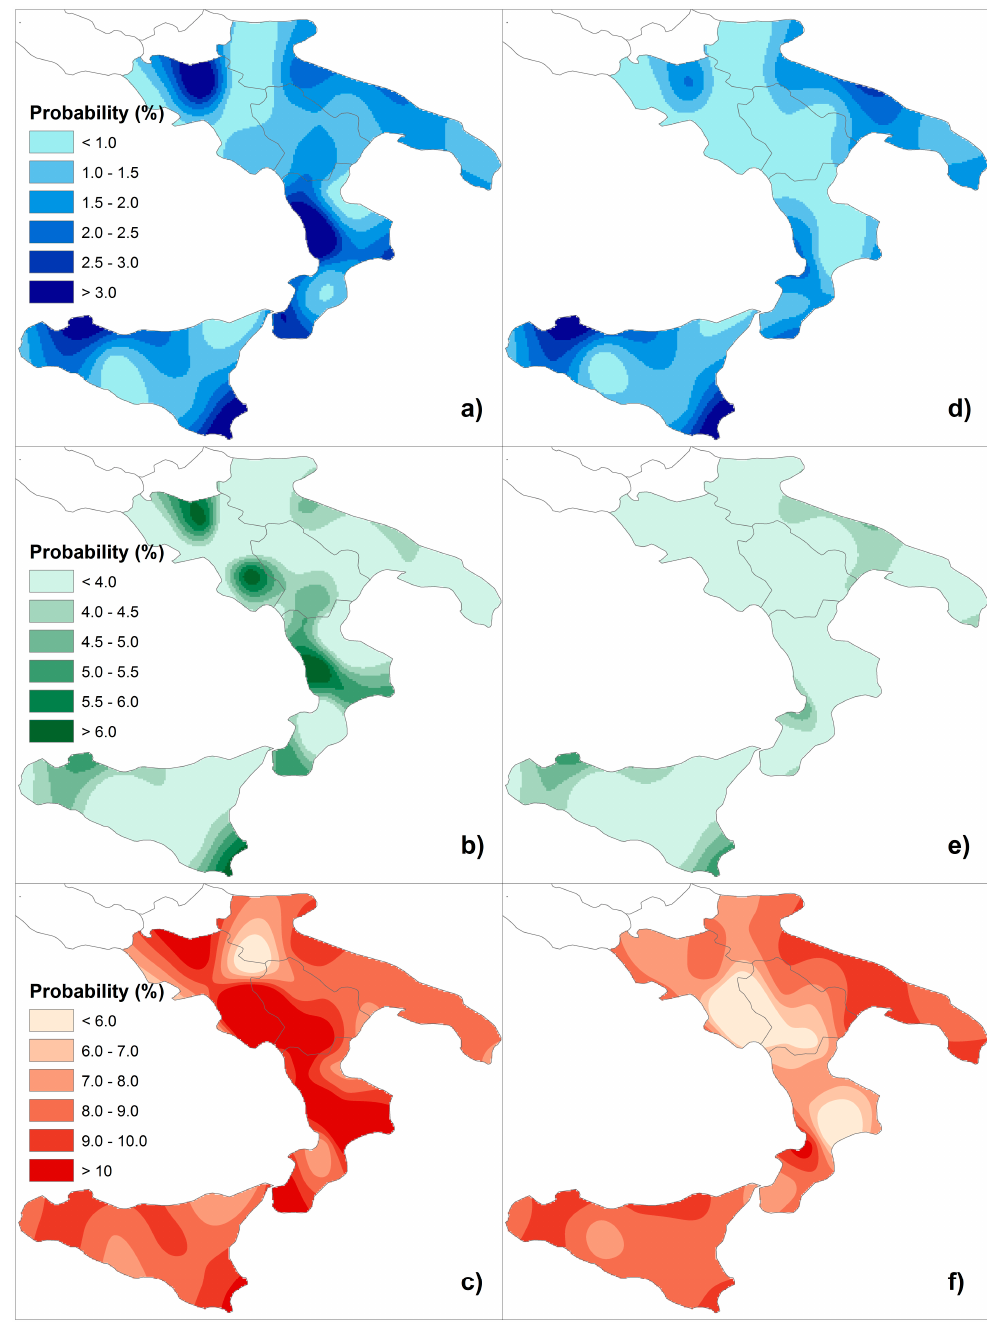
Figure 6. Maps of the monthly occurrence probabilities of Extreme drought ( a ), Severe drought ( b ), Moderate drought ( c ), Extremely wet ( d ), Severely wet ( e ) and Moderately wet ( f ) conditions for the 24-month SPI.